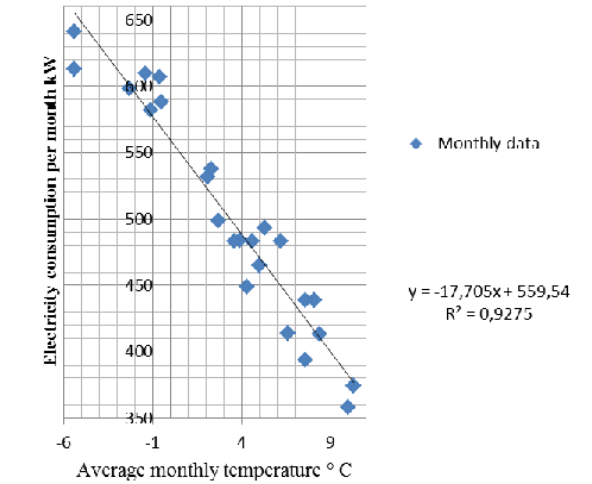
Fig.5. Monthly electricity consumption in kWh besed on average monthly temperature